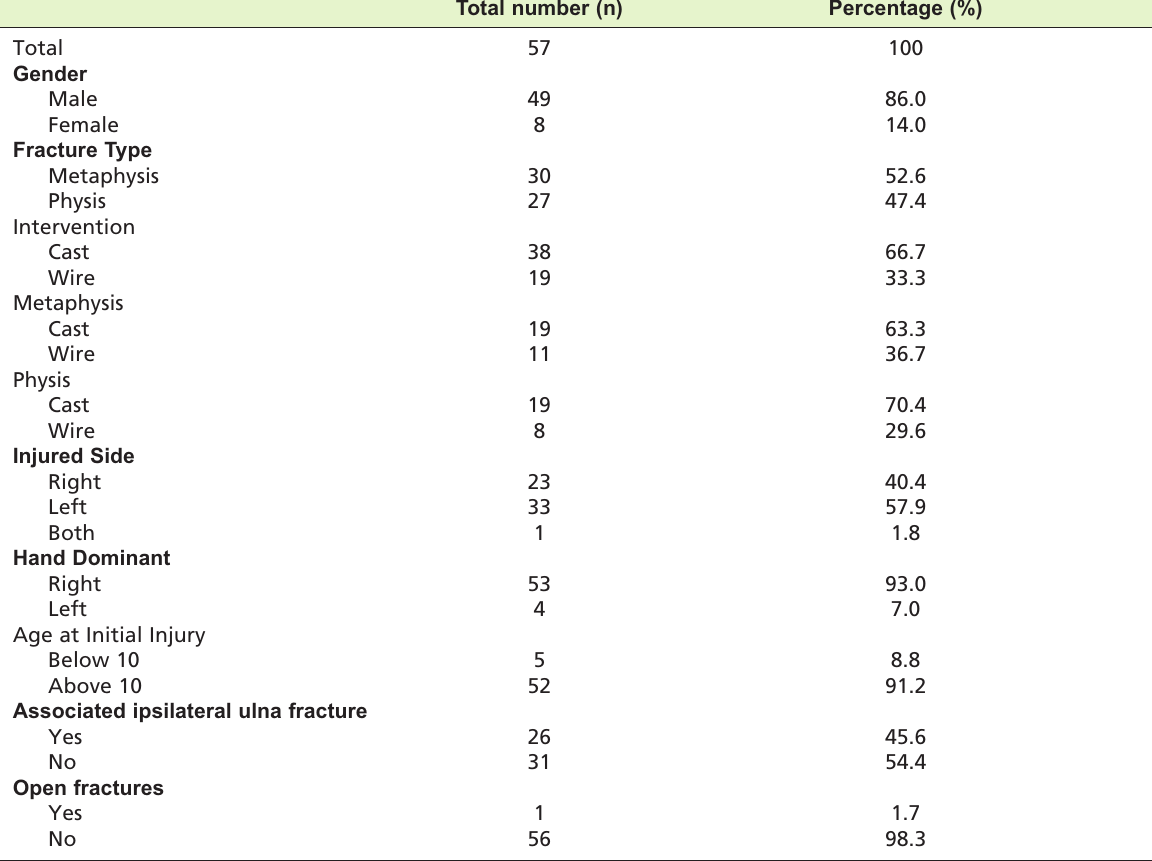
Demographic details of the patients and their Table II: